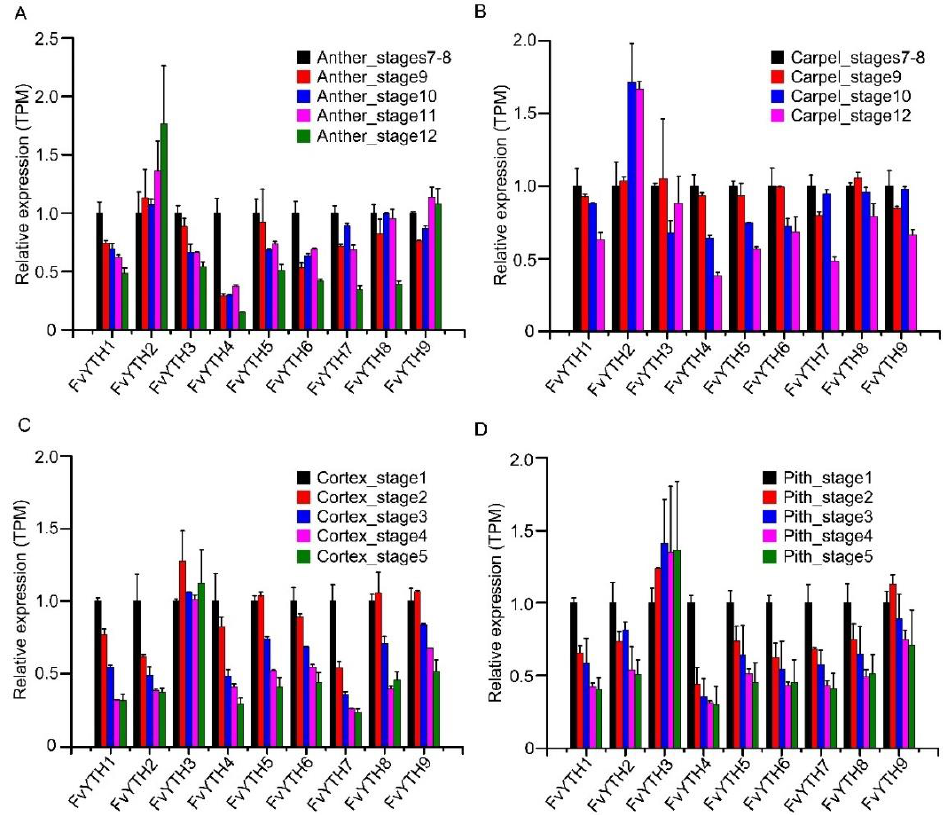
Figure 7. Expression trends of FvYTH genes in different stages of organ development. The expression trends of FvYTH genes in different development stages of anther ( A ), carpel ( B ), cortex ( C ), and pith ( D ). The TPM value of the selected first stage was normalized as 1.